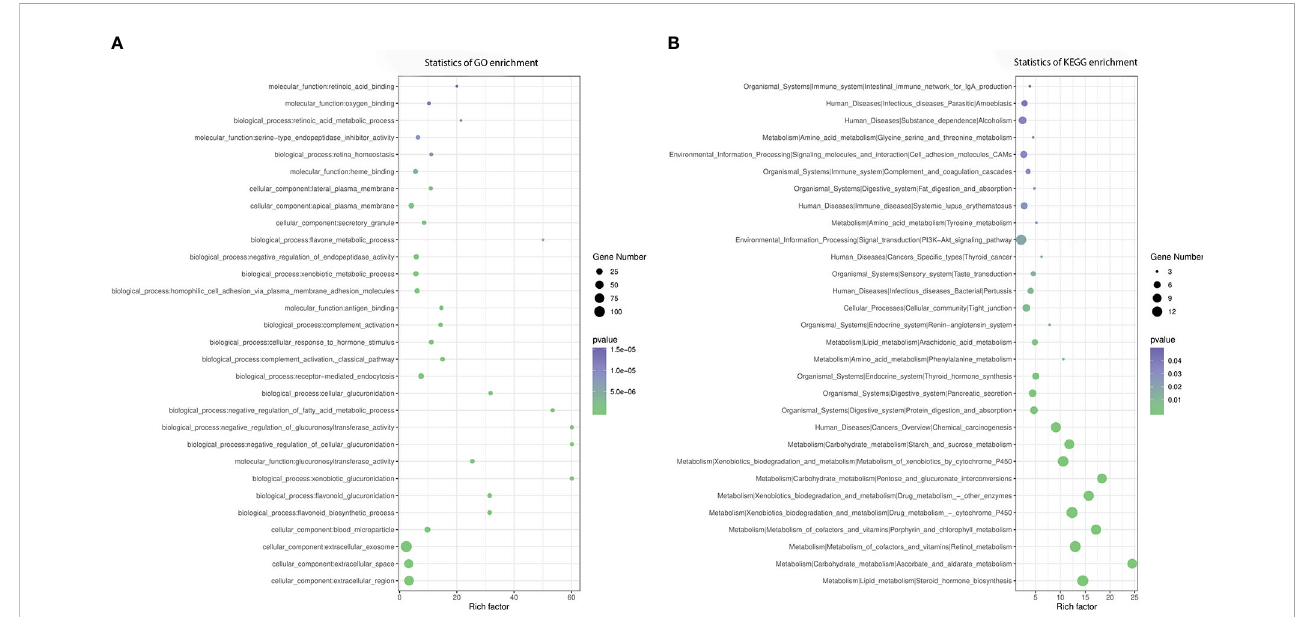
FIGURE 5 GO and KEGG enrichment analysis of DEGs. (A) GO analysis of differentially expressed genes, (B) KEGG analysis of differentially expressed